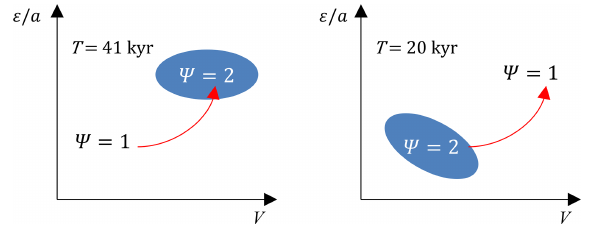
Figure 1. A typical illustrative (cid:57) ( V,ε/a ) function. Red arrow rep- resents hypothetical trajectory of the Pleistocene history of the sys- tem, which includes the following: from doubled precession peri- ods of the early Pleistocene to doubled obliquity periods of the late